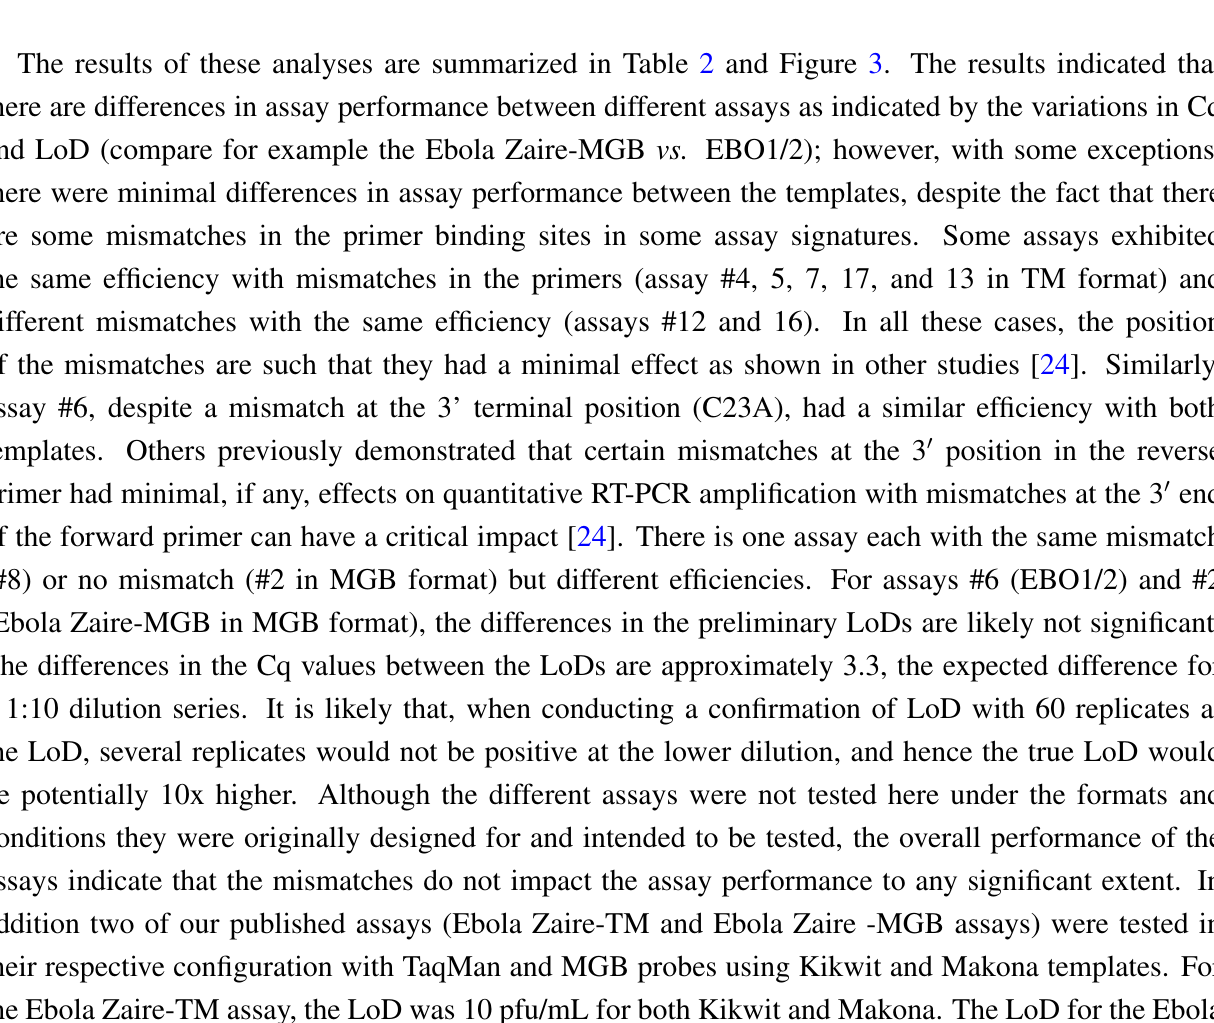
Figure 3. SYBR Green RT-PCR assay results as a function of pfu/mL vs. Cq (cycle of quantitation). Each individual assay was run with a 1:10 serial dilution of either EBOV Kikwit ( A ) or EBOV Makona ( B ). Each PCR was run in triplicates, and the lowest virus concentration indicated is the lowest virus dilution that still resulted in all three replicates being called positive. For each assay, a sample was considered positive if the Cq value was less than the average of two no template controls. The error bars indicate the standard deviation of the